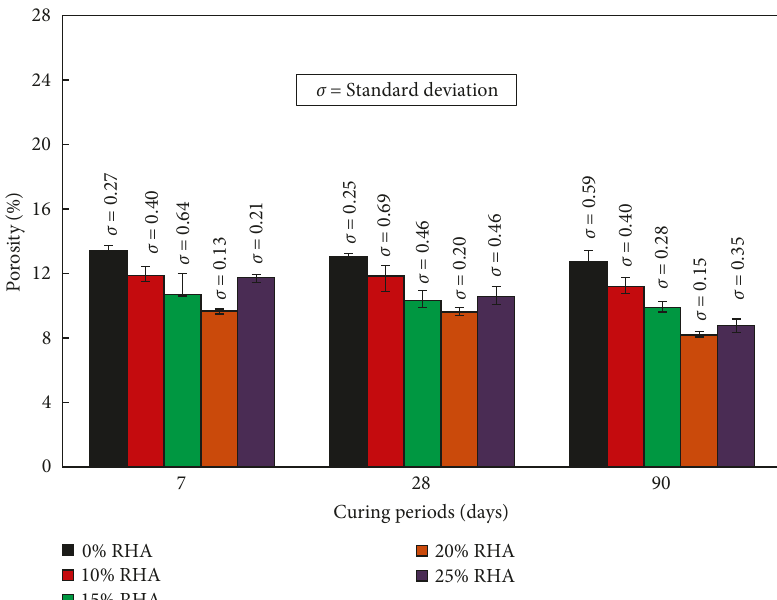
Figure 6: Porosity of RBAC at 7, 28, and 90 days of